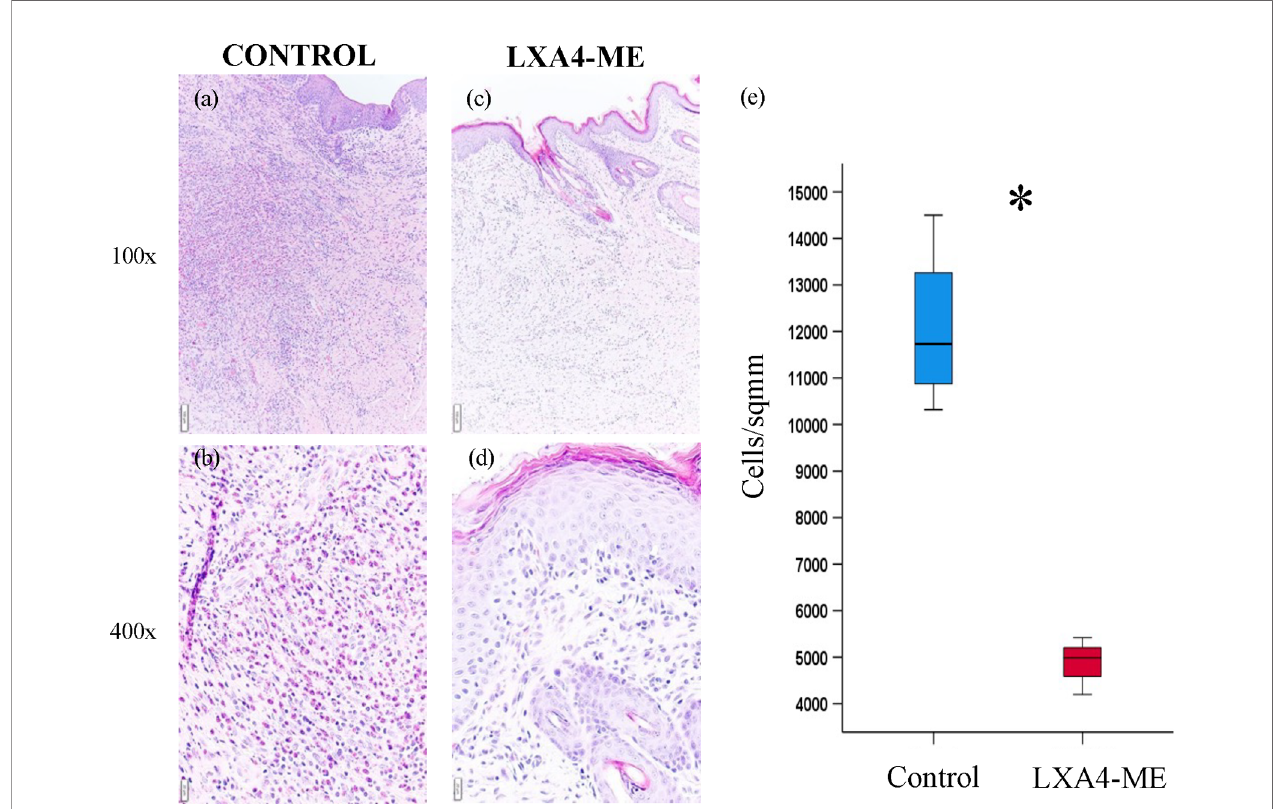
FIGURE 3 | Microscopic examination of images of representative tissue specimens stained with hematoxylin and eosin (H&E) captured at 100x (A, C) and 400x (B, D) magni fi cation. The scale bars represent 100 um (A, C) and 20 um (B, D) . Automated quanti fi cation of in fl ammatory cell in fi ltrate with Aperio Imagescope software con fi rmed signi fi cant reduction of in fl ammatory cell density in animals treated with methyl-ester of lipoxin A 4 (LXA 4 -ME) (median=4986; 25 th ; 75 th percentile=4784, 5099) compared to control ones treated with PBS (median=11730, 25 th ; 75 th percentile=11158, 12643) (E) (statistically signi fi cant at *P < 0.05, Mann-Whitney U test; n=4 animals/group). The averages of three regions per animal were used for